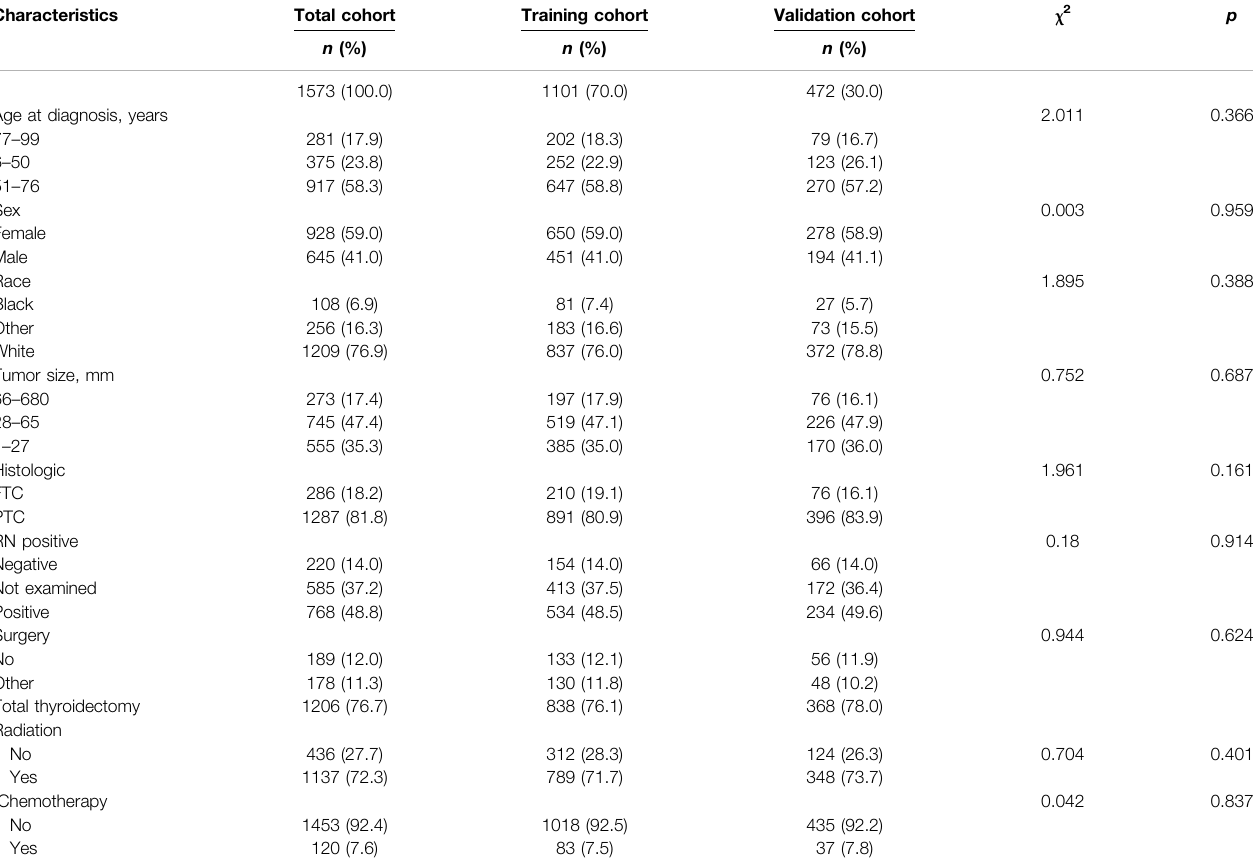
TABLE 2 | The baseline characteristics of the training and validation sets used in the prognostic model.